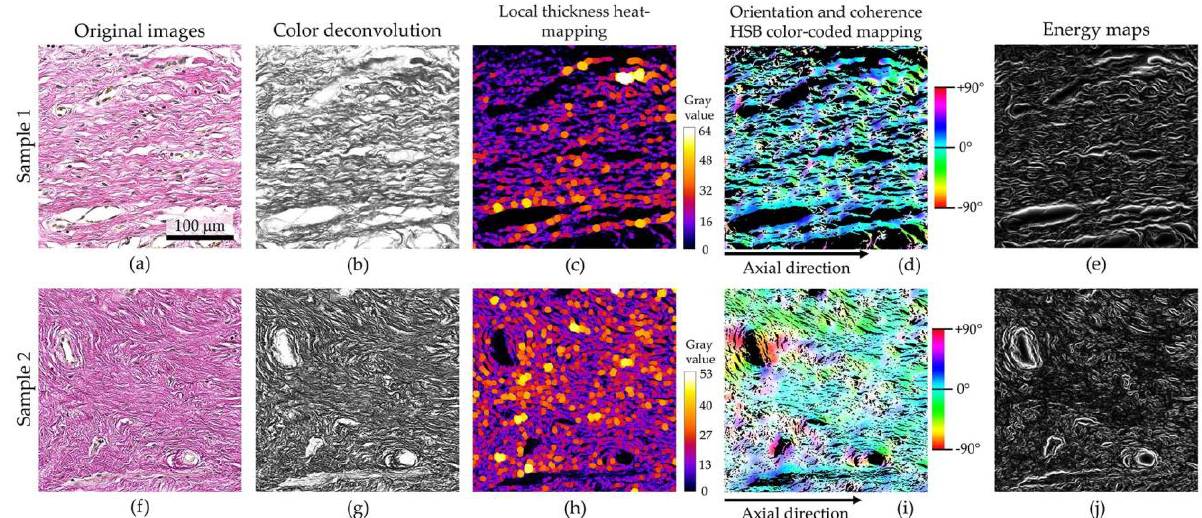
Figure 1. An example of a quantitative analysis of collagen bundles on histological sections in vaginal wall prolapse. Both samples have a different structure of collagen bundles: sample 1 ( a–e ) contains loose tissue with sinuous collagen bundles that have a dominant direction and are not subjected to laser preoperative treatment; sample 2 ( f – j ) is represented by dense tissue with numerous collagen bundles after laser preoperative treatment. ( a , f )—original histological slide images; ( b , g )—color deconvolution, resulting 8-bit image representing dye transmission of collagen fibers; ( c , h )—local thickness analysis with heat-mapped visualization (more purple/black = less thick; more yellow/white = more thick), sample 1 has thin collagen bundles, sample 2 has thicker collagen bundles due to the increase in tissue density (10.6 ± 12.4 vs. 14.9 ± 10.2 a.u.); ( d , i )—HSB color-coded map shows the orientation of collagen bundles relative to the axial direction and their coherence, hue—local orientation, saturation—coherence, brightness—original image; ( d )—the collagen bundles in sample 1 have an orientation close to the axial direction (2.2 ± 1.9°) and high coherence (0.33 ± 0.04 a.u.) due to the alignment of the bundles; ( i )—the collagen bundles in sample 2 deviate from the axial direction (17.8 ± 20.7°) and have reduced coherence (0.14 ± 0.03 a.u.) due to the loss of a single dominant direction; and ( e , j )—the energy map shows high values at the border of collagen bundles, sample 1 has less energy than sample 2 (6234 ± 965 vs. 8639 ± 838 a.u.).